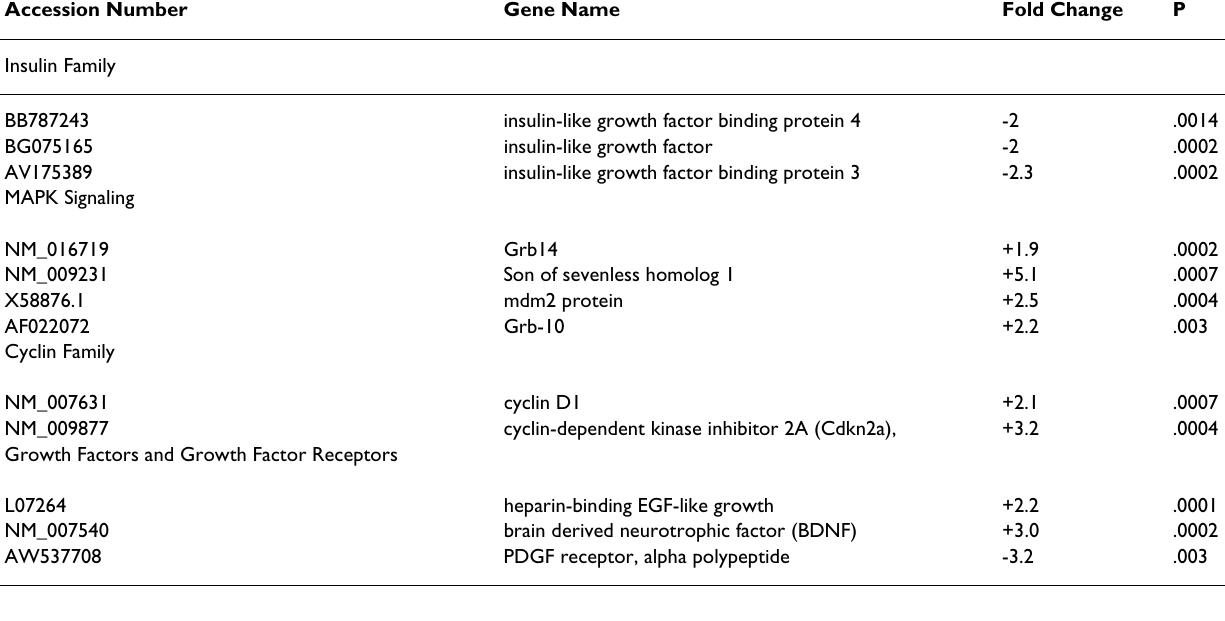
Table 1: Expression of proliferation associated genes on Ebp1 knock out versus wild type